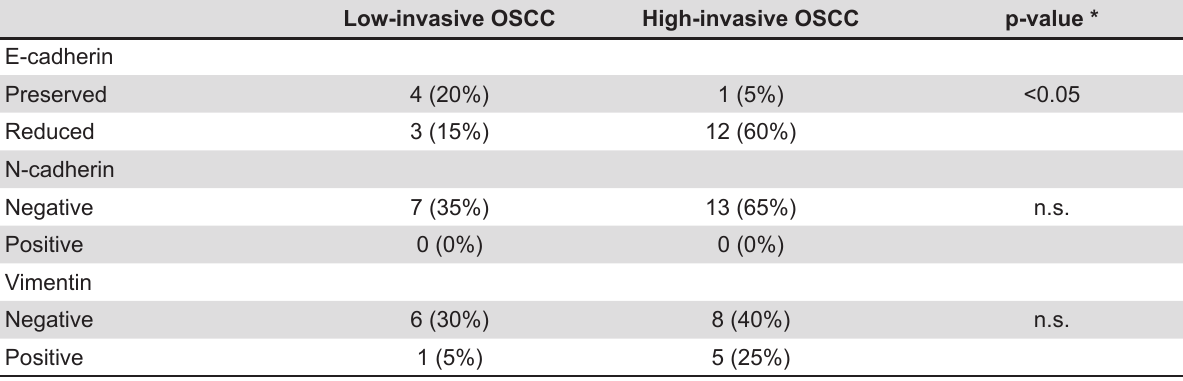
Table 2- E-cadherin, N-cadherin and vimentin expression at the invasive front (IF) of low- and high-invasive oral squamous cell carcinoma